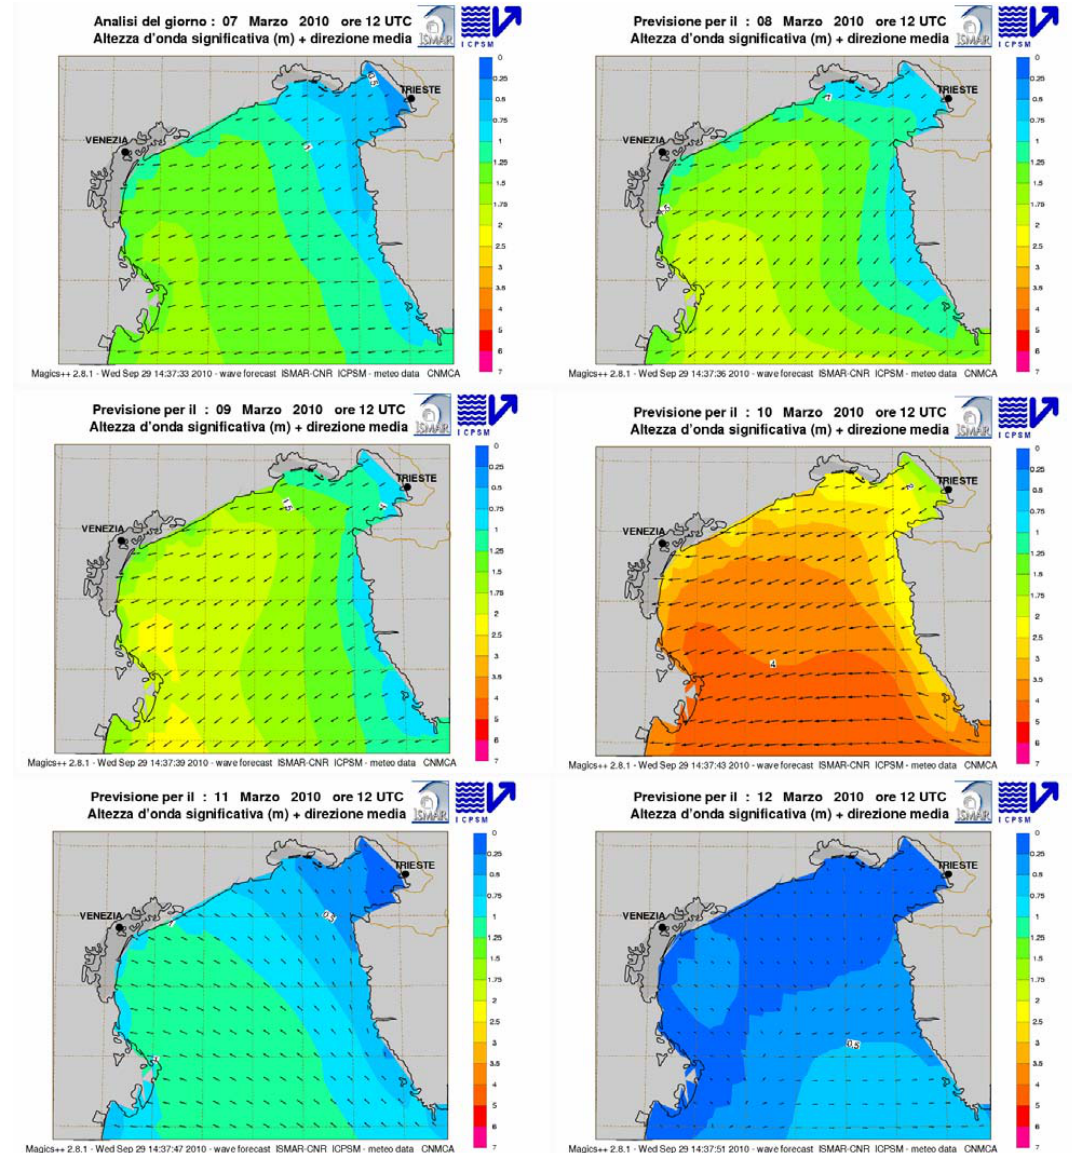
Figure 5 – Wave fields in the northern Adriatic Sea, respectively of the analysis and the 24, 48, 72, Fig. 5. Wave fields in the northern Adriatic Sea, respectively, of the analysis and the 24, 48, 72, 96, 120h forecasts produced on 10 March 2010. The wind and wave representation is similar to the one in Fig. 4. The analysis field corresponds to the one shown in Fig.